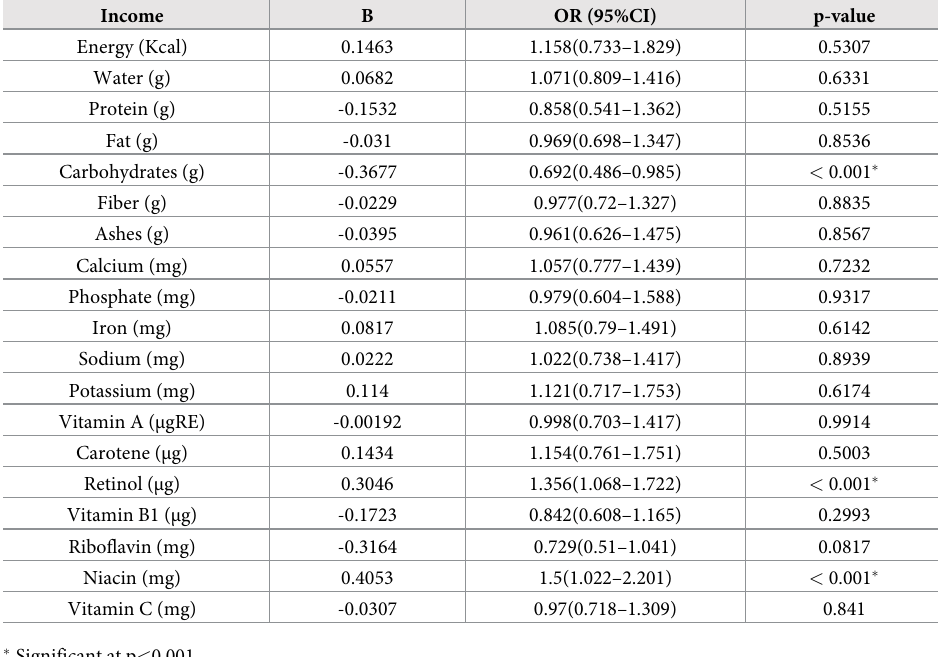
Table 4. Multiple regression analysis for all dietary factors affecting hearing impairment in noise-exposed